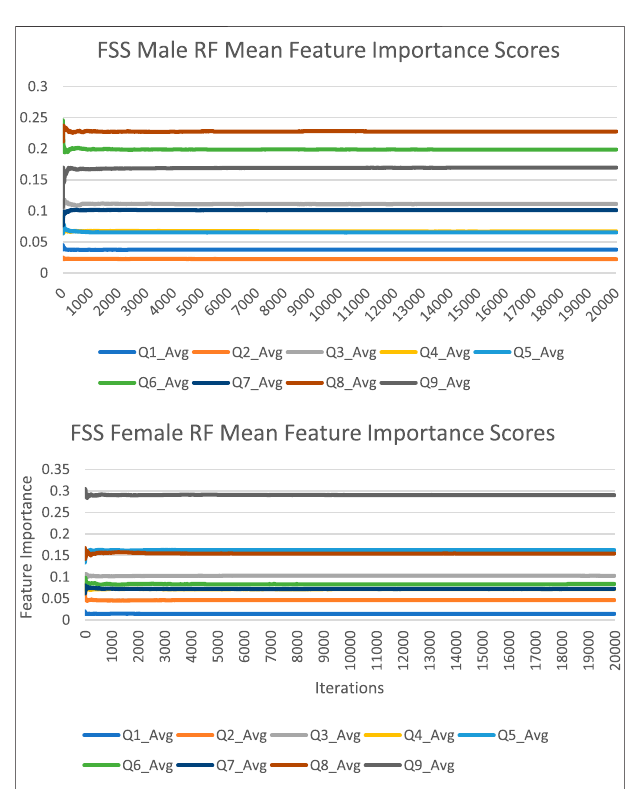
FIGURE 3 | FSS male and female random forest mean feature importance score